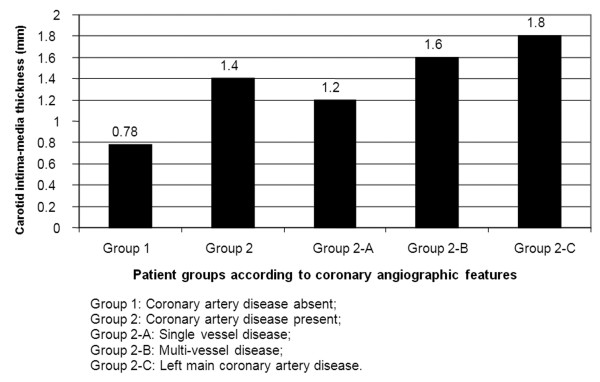
Comparison of carotid intima-media thickness with coronary angiographic findings.